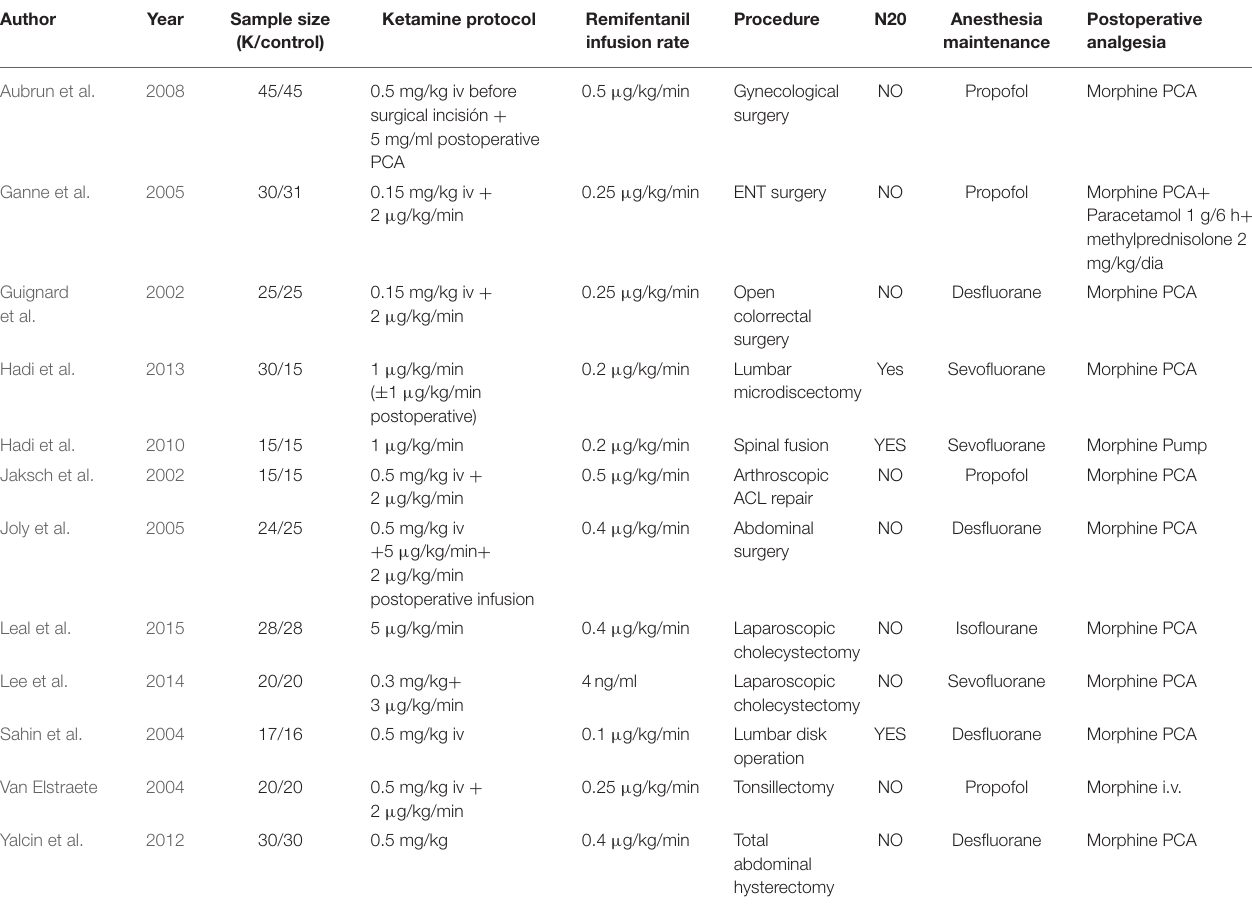
TABLE 2 | Details of the selected